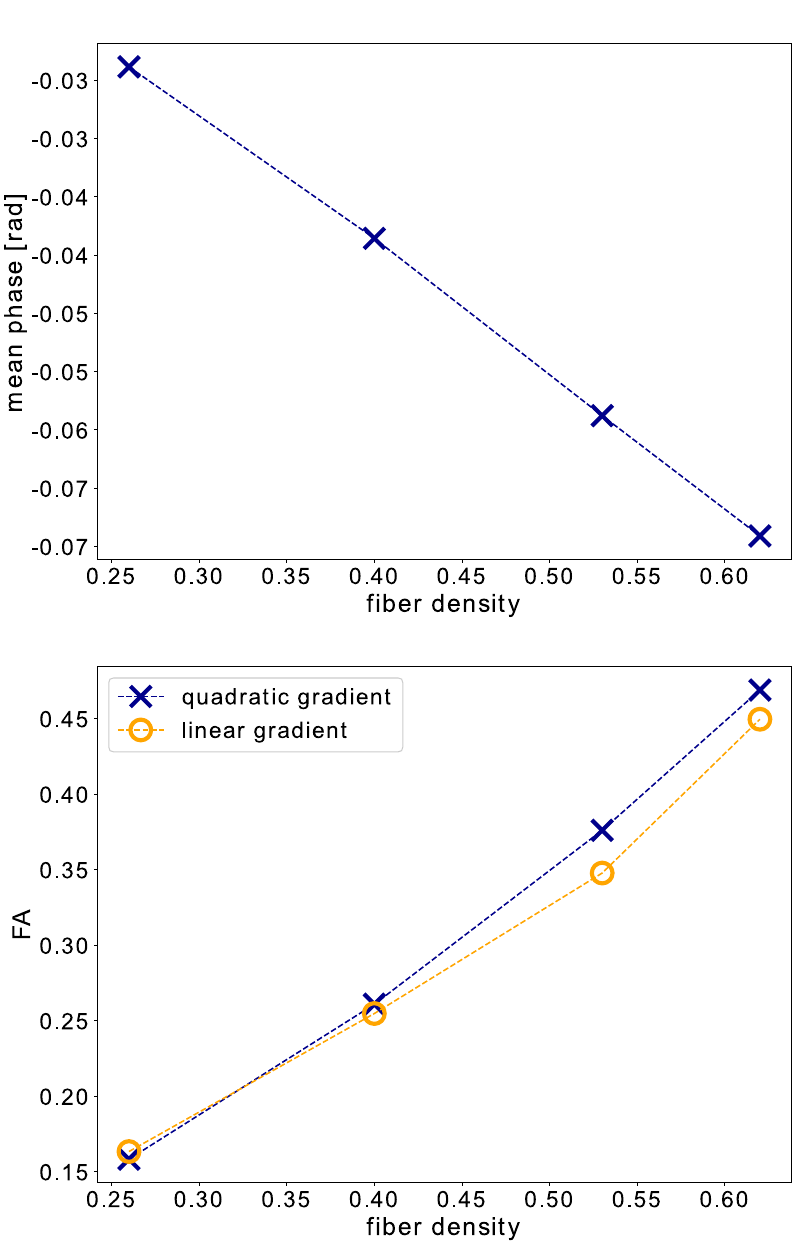
Fig 5. The results of the numerical fibre phantom experiment B1: The mean net phase (top) and FA (bottom) versus the fibre density FD of the phantom.